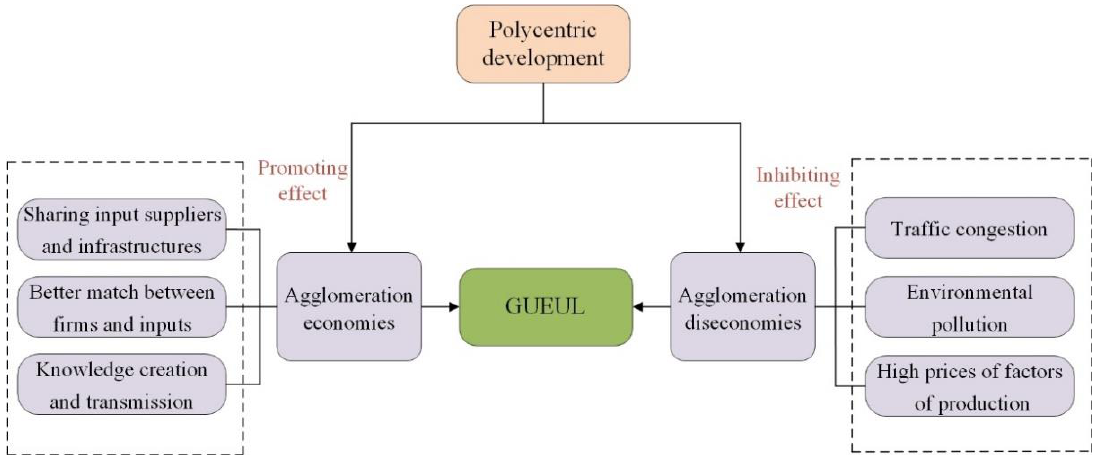
Figure 1. The mechanism through which polycentric development affects GUEUL. Supporters of a more polycentric pattern of urban development suggest that the poly- centric spatial structure allows reaping agglomeration economies and, meanwhile, avoids at least some of the agglomeration diseconomies, thus having a positive effect on